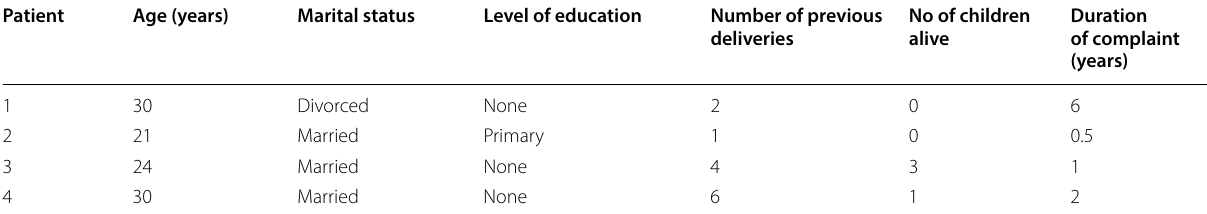
Table 2 Socio-demographic characteristics of the patients Patient